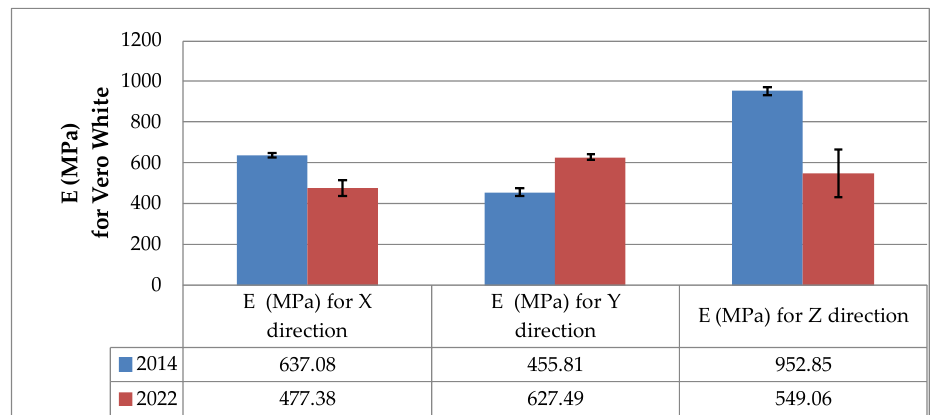
Figure 6. Modulus of elasticity E of the as-printed (December 2013) and naturally aged (July 2022) specimens based on FullCure 720 resin.